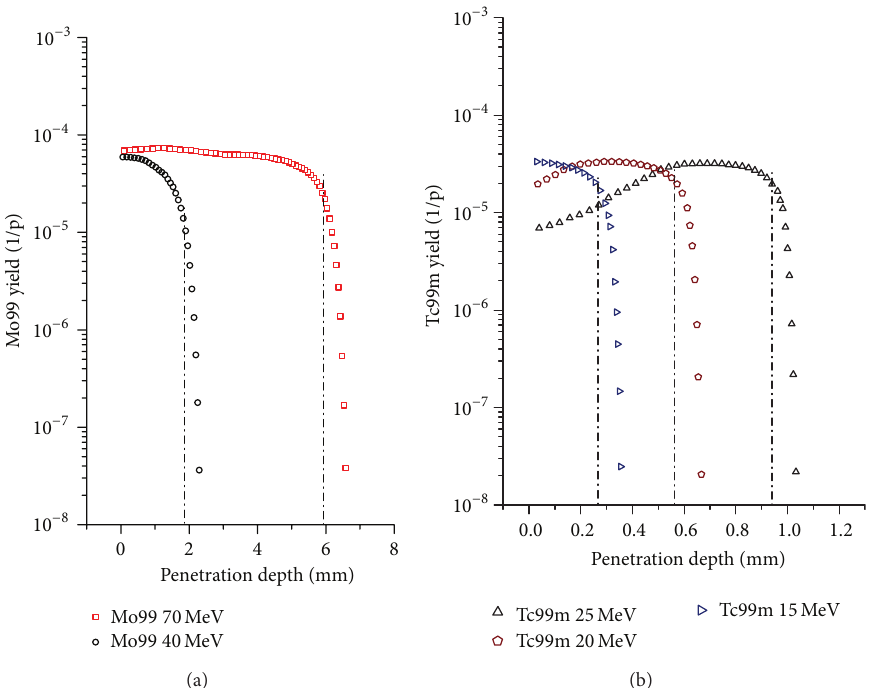
Figure 7: The distributions of the nuclide yields, normalized per incident proton, versus penetration depth, calculated inside 99.05% 100 Mo- enriched samples: (a) 70 MeV and 40 MeV are considered for 99 Mo production; (b) the same plot for 15, 20, and 25 MeV beam, in case of direct 99𝑚 Tc production. The eye-guide vertical lines show the recommended sample thicknesses to get an optimized